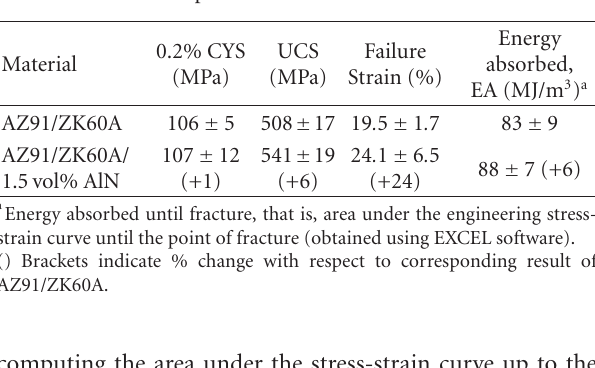
Table 4: Results of compressive testing of AZ91/ZK60A and